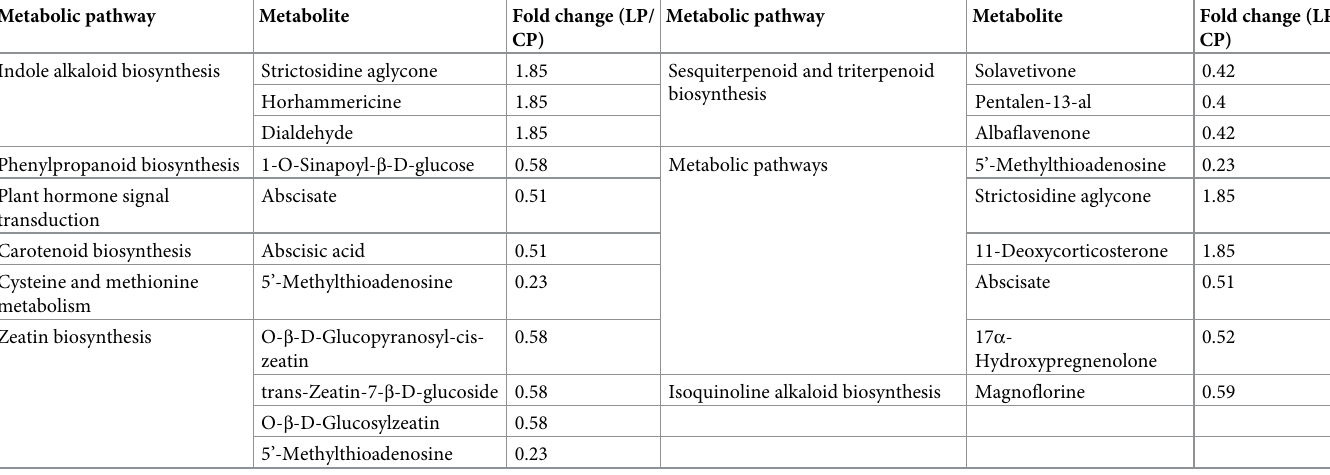
Table 1. Differentially expressed metabolites in roots of Xindong 20 at day 3 under simulated drought stress in LP and CP treatments � . Metabolic